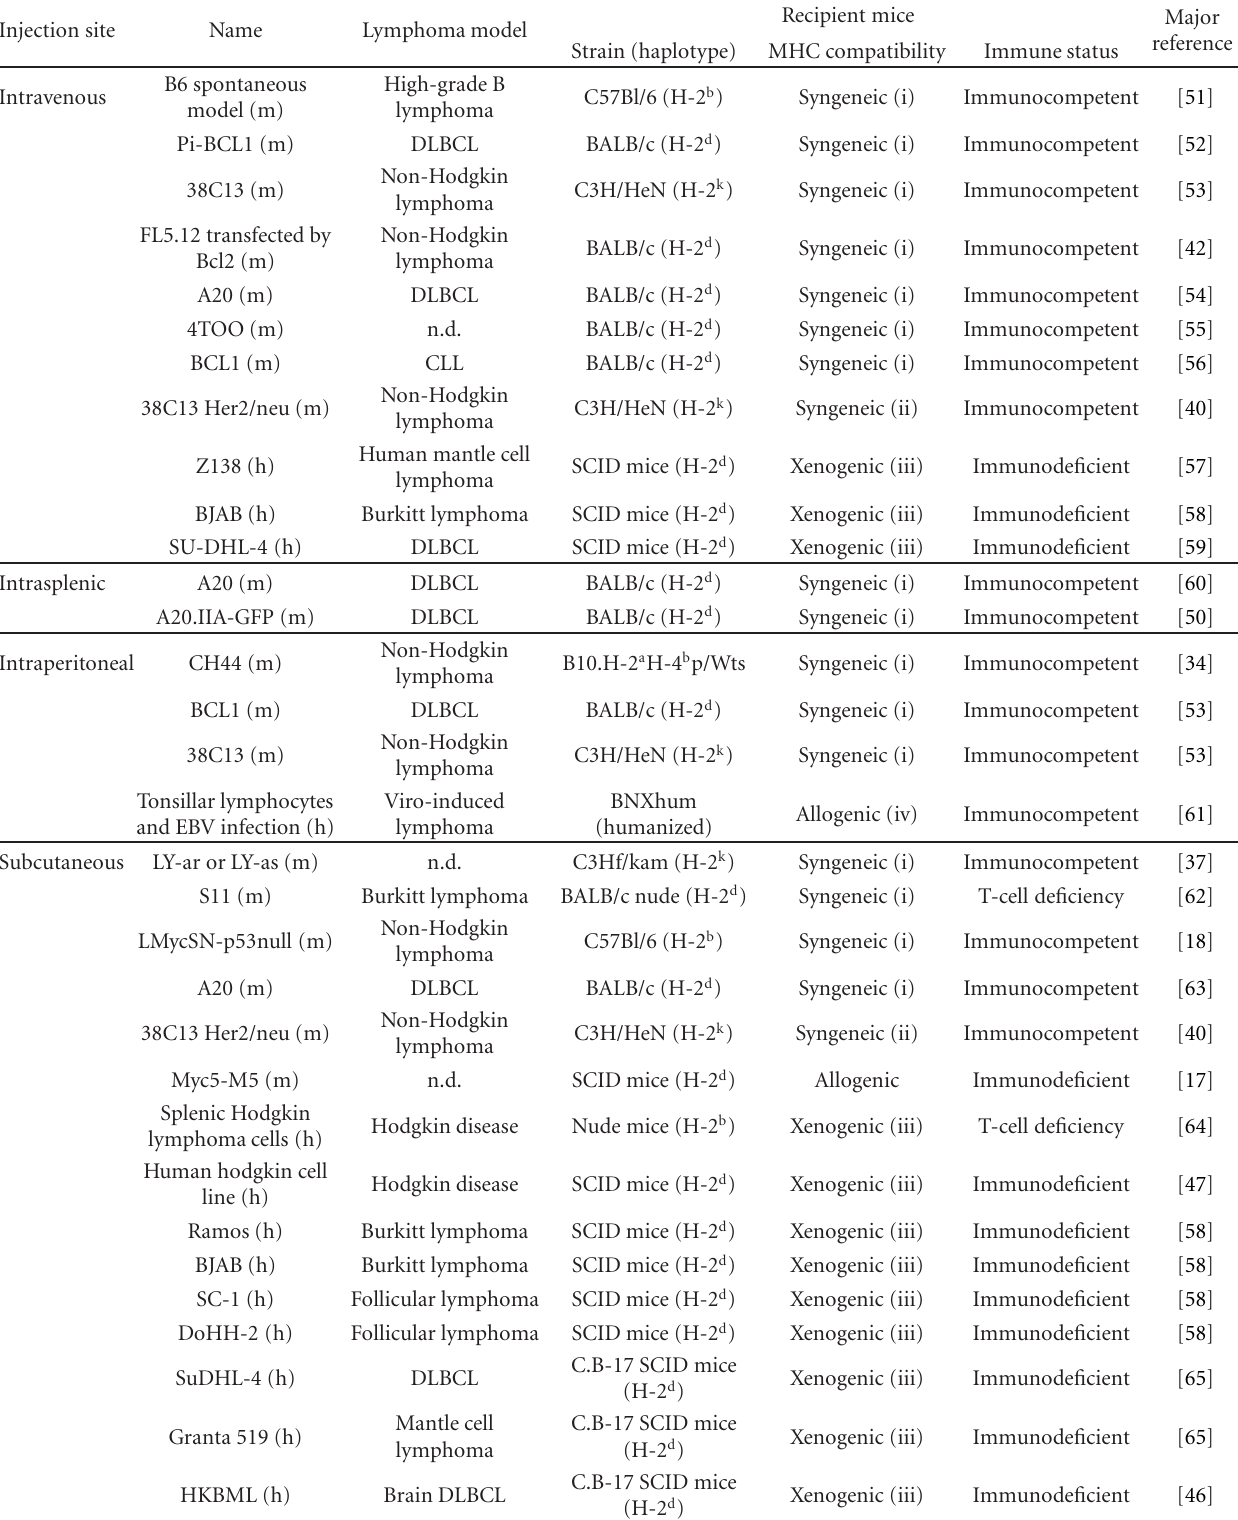
Table 3: Induced models of B-cell lymphoma. (m): murine origin; (h): human origin; (i): syngeneic models; (ii): syngeneic models with murine tumor cells engineered to express human antigens; (iii): xenogenic models; (iv): humanized models; CLL: chronic lymphocytic leukemia; DLBCL: di ff use large B-cell lymphoma; MALT: mucosa associated lymphatic tissue; n.d.: not determined; PCL: primary cerebral lymphoma; PCNSL: primary central nervous system lymphoma; PIOL: primary intraocular lymphoma; SCID: severe combined immune